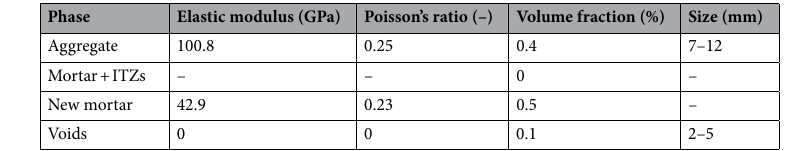
Table 13. RAC properties at mesoscale, Thilakarathna et al. 28